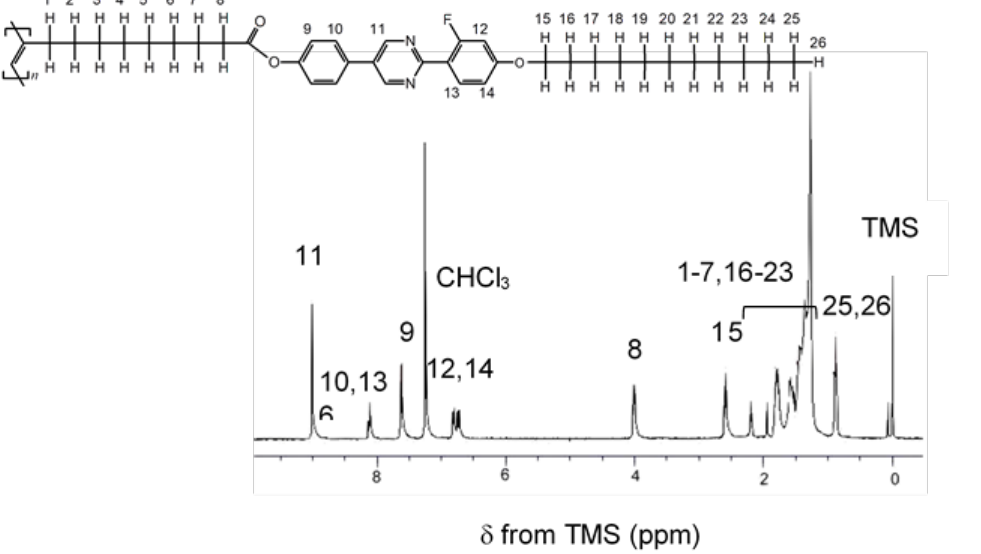
Figure 2. 1 H NMR spectrum of poly(Ac–Pyr) in CDCl 3 .